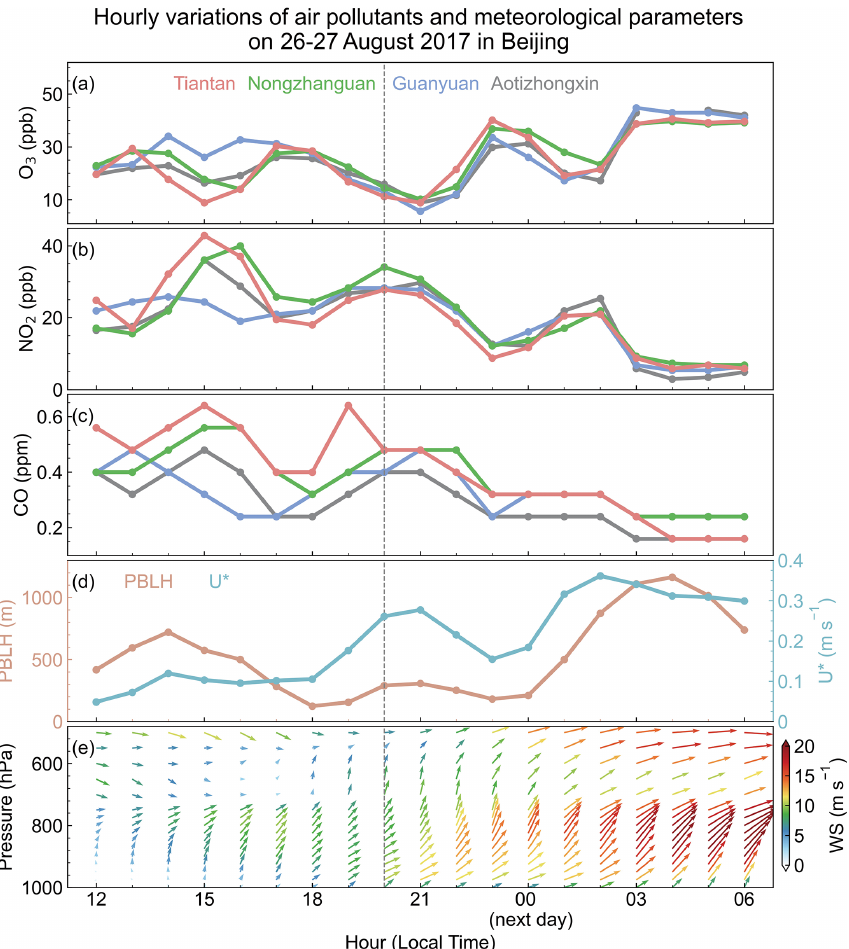
Figure 9. Hourly variations in air pollutants and meteorological parameters at four sites during a Beijing NOE event on 26–27 August 2017 that was induced by low-level jets. Panels (a) , (b) , and (c) show the evolution of ozone, NO 2 , and CO, respectively. Panel (d) shows the evolution of the PBLH and frequent velocity ( U ∗ ). Panel (e) shows the temporal variation in the horizontal wind profiles, with the color representing the wind speed. The vertical dashed line marks the start of